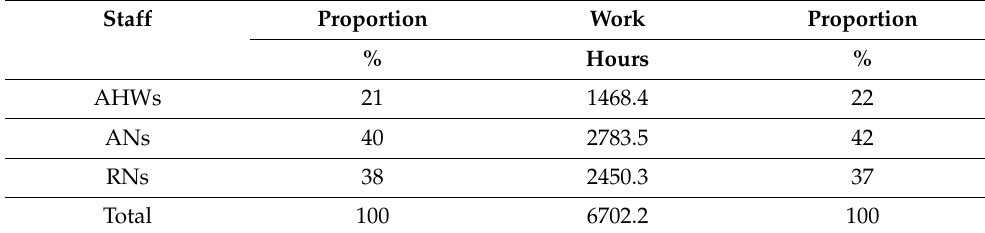
Table 2. Descriptive